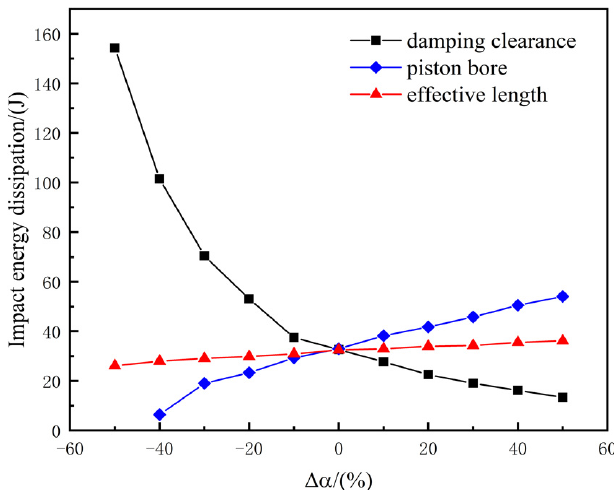
Figure 22. Effect of structural parameters on impact energy dissipation.